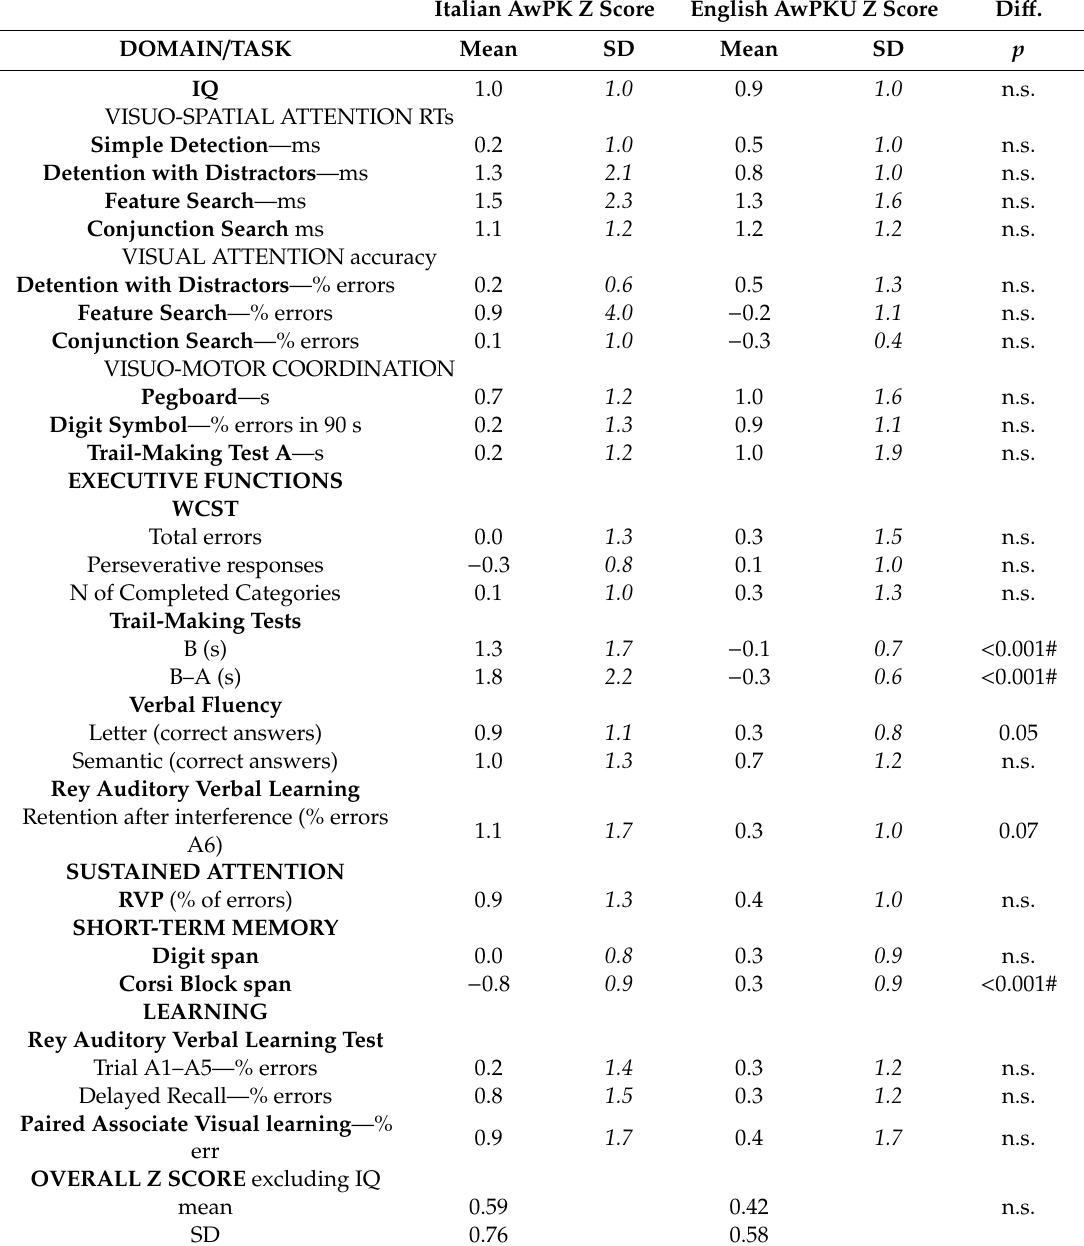
Table 3. Cognitive Performance of English and Italian PKU Groups in Term of Z Score Computed from Relative Control Groups Matched for Age, Gender, and